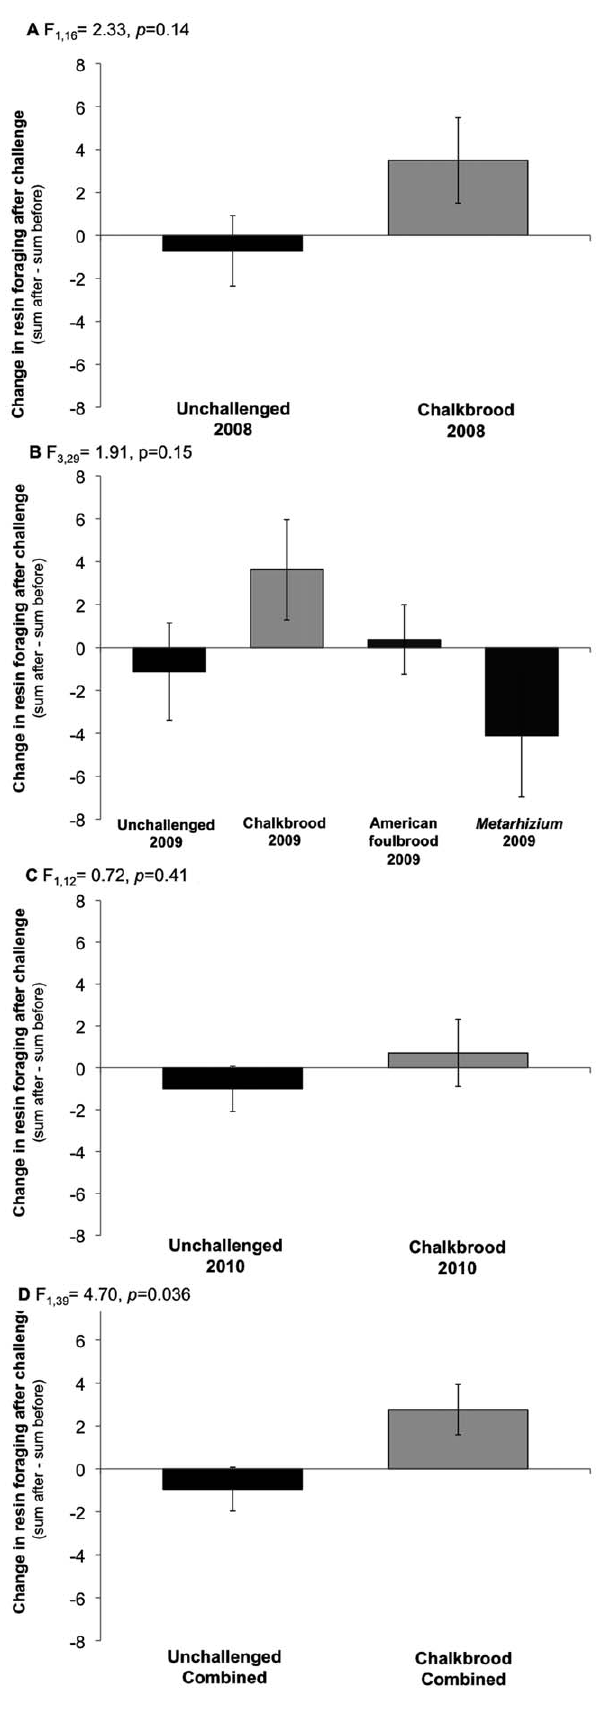
Figure 1. Change in resin foraging rates before and after challenge. Data were analyzed using ANOVA for each series with p- values reported within each graph. A) 2008 (n=7 unchallenged, n=10 challenged); B) 2009 (n=8 for unchallenged, chalkbrood, and American foulbrood; n=9 for Metarhizium ; C) 2010 (n=6 unchallenged, n=7 challenged); D) Data combined for unchallenged and chalkbrood challenge treatments over the three years of